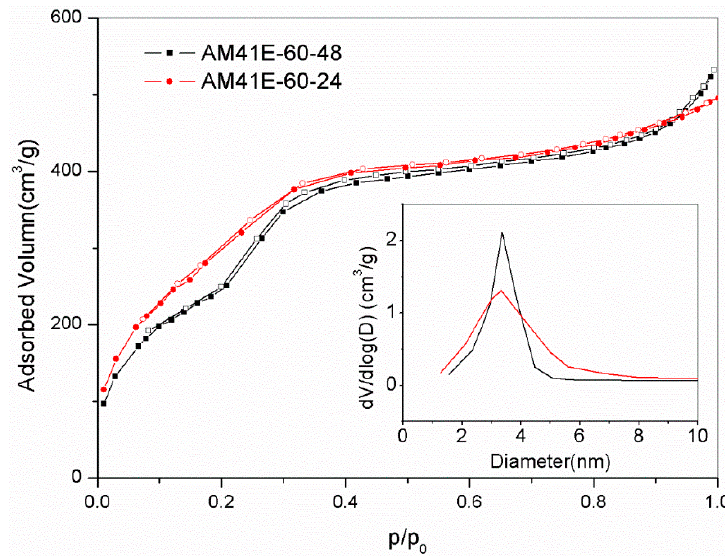
Figure 12 . N 2 adsorption–desorption isotherms for AM41E60-48 and AM41E60-24. Figure 12. N 2 adsorption–desorption isotherms for AM41E60-48 and